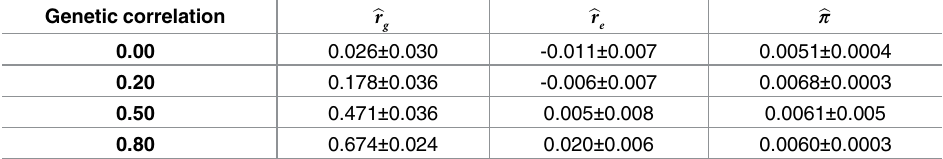
The assigned r e and π are 0 and 0.006, respectively.